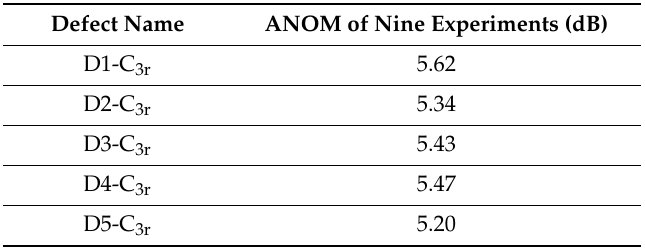
Table 4. ANOM values for nine experiments (C100 \